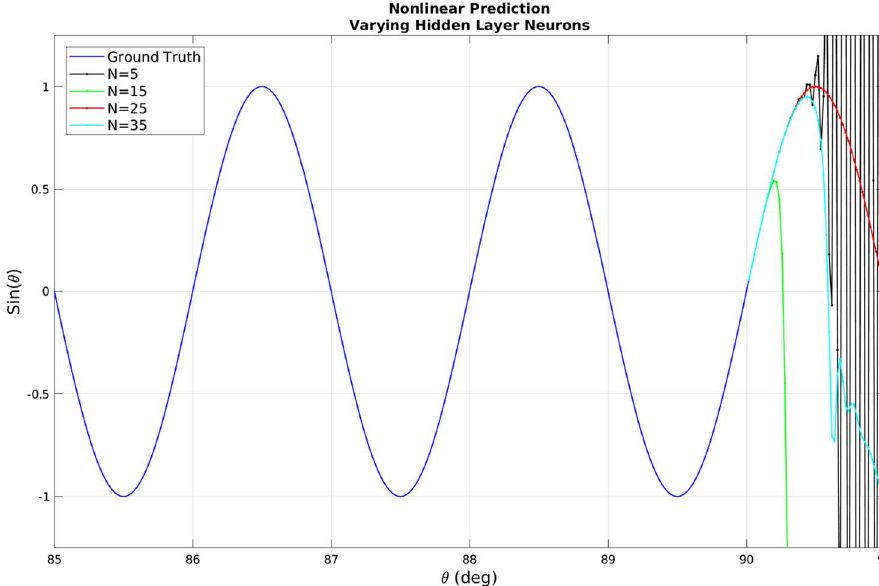
Fig. 1. Prediction using different sizes of the hidden layer for a toy nonlinear model. The ground truth is shown in blue line, while the black, green, red, and cyan lines represent the prediction results using 5, 15, 25, and 35 hidden layers,